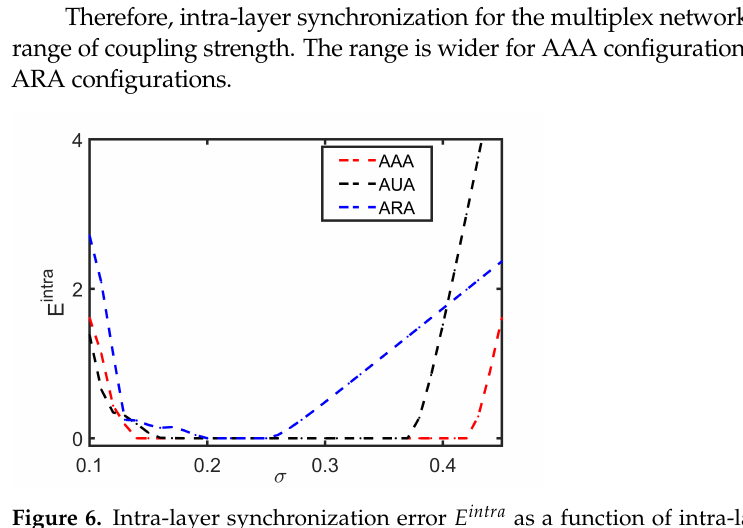
Figure 6. Intra-layer synchronization error E intra as a function of intra-layer coupling strength σ for the fixed value of inter-layer coupling strength λ = 0.01. Red, black, and blue dashed curves represent the synchronization errors for AAA, AUA, and ARA